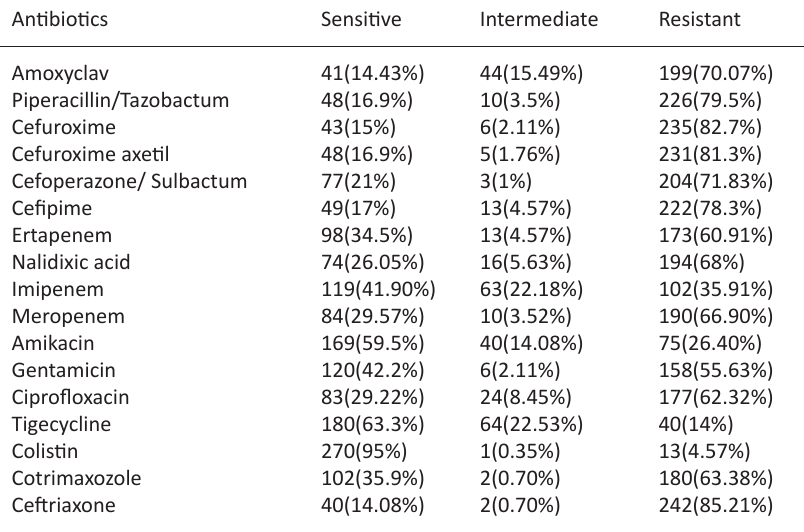
Table 4. Antibiotic resistance pattern of Klebsiella Antibiotics